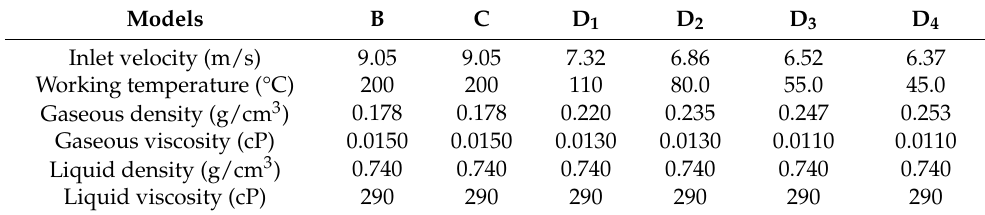
Table 2. Boundary conditions of the cyclone